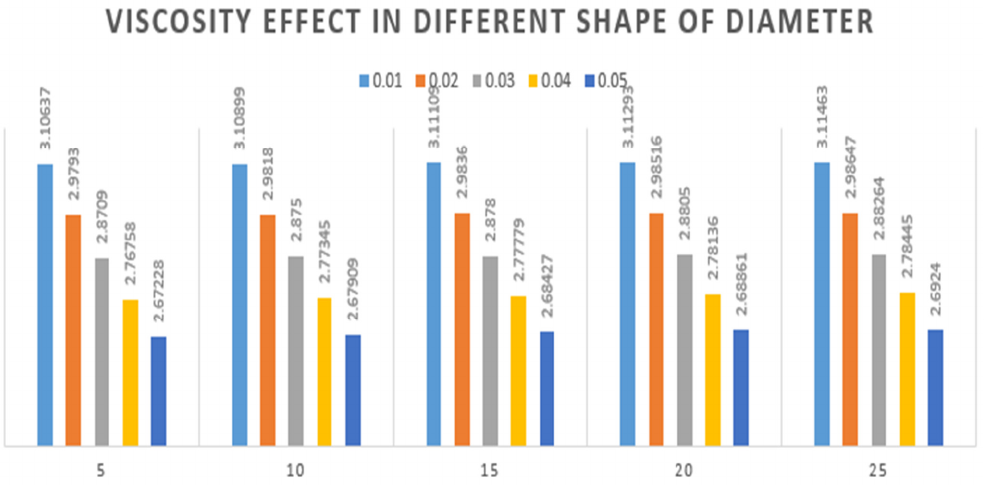
Figure 4. The quantity of hybrid NP affects the viscosity coloring process. Figure 5 reveals the Forchheimer number () impact of the radial velocity profile influenced by the fixed values = 2, = 1, = = 0.01,1 = 2 = 10, = 2, =